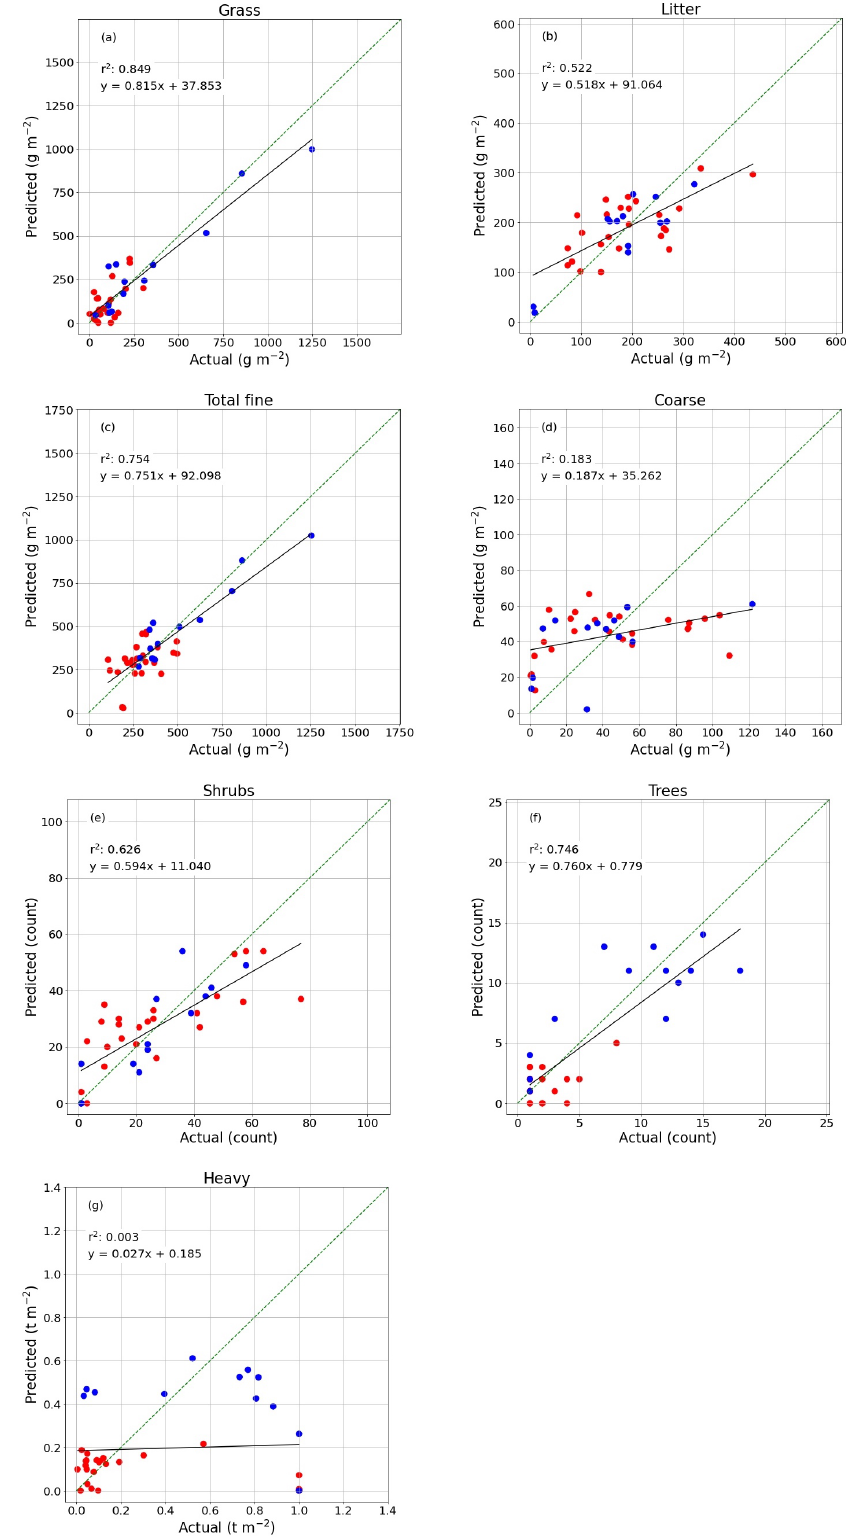
Figure A2. Training data values for ( a ) grass, ( b ) litter, ( c ) total fine fuel, ( d ) coarse, ( e ) shrubs, ( f ) trees and ( g ) heavy. Plots in Botswana are shown in red and Niassa in